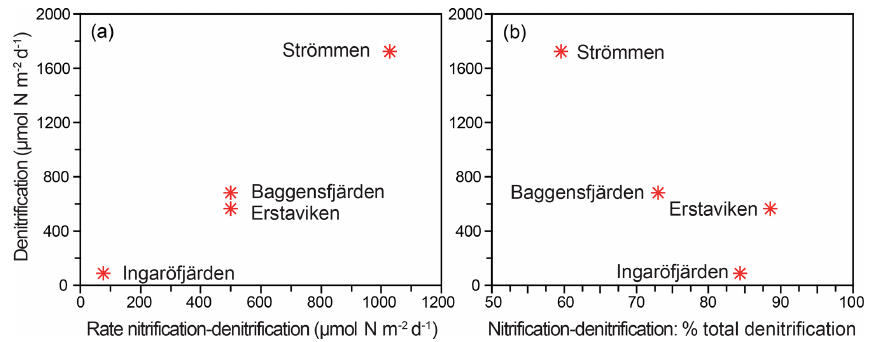
Figure 8. Relationship between total denitrification rates and denitrification driven by NO − as process rates (a) and as a percentage of total denitrification (b) .